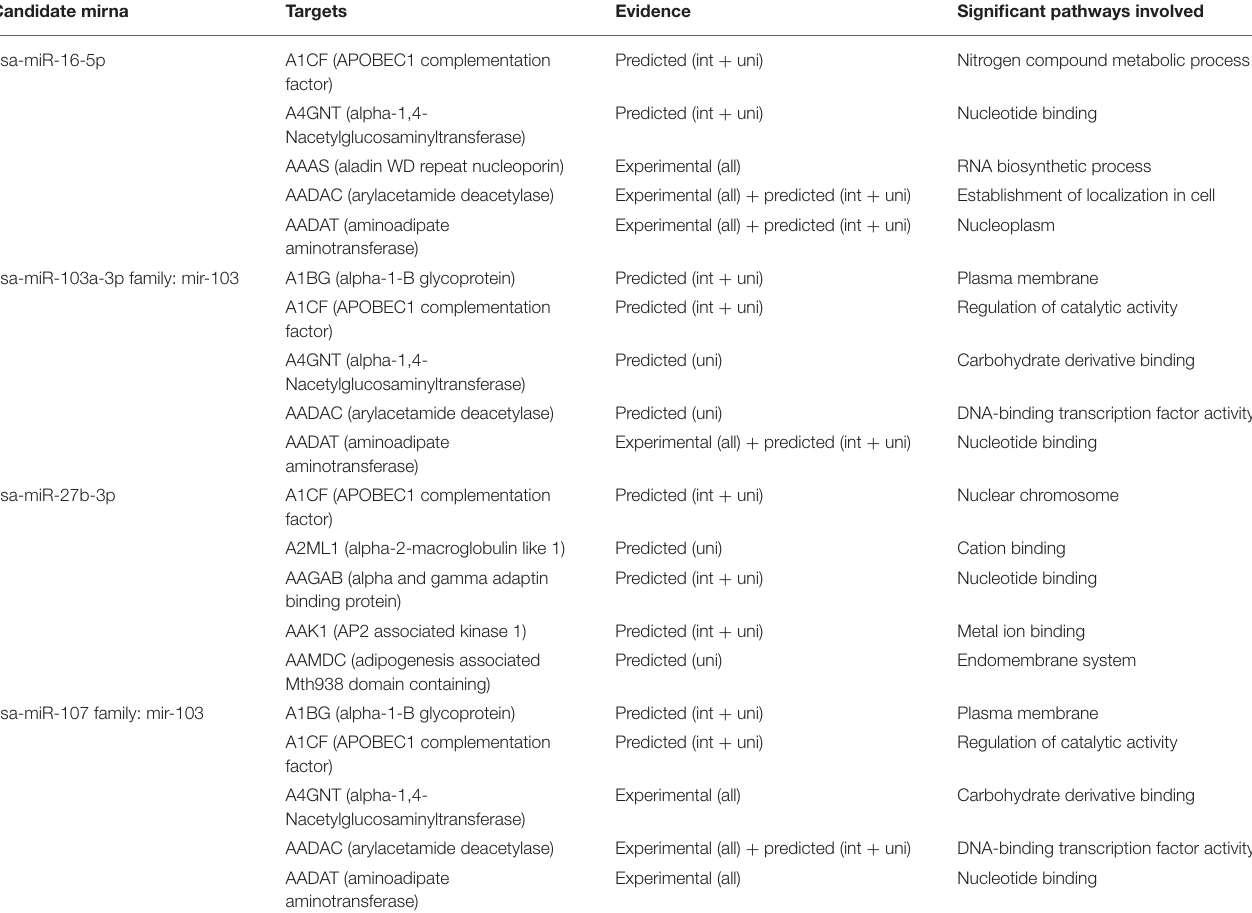
TABLE 3 | A list of predicted or validated targets together with putative pathways of microRNAs dysregulated in plasma samples of pregnant women with FGR using MirPathDB 2.0. Candidate